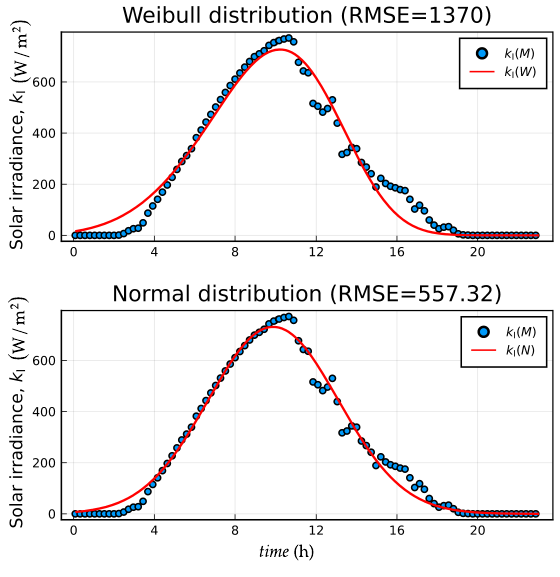
Figure 15. Solar irradiance prediction using Weibull and normal distributions for July-01-2018. Root mean square errors (RMSE) shows that the normal distribution is better than Weibull distribution. For the Weibull (cid:0) (cid:1) distribution, ( k , λ , α , β ) = 5.25,2.7 × 10 − 3 ,8.7 × 10 − 4 ,4.7 × 10 − 3 , and for the normal distribution ( µ , σ , α , β ) = (cid:0) (cid:1) 1.9 × 10 − 4 ,5.4 × 10 − 4 ,1.8 × 10 − 3 , − 2 × 10 − 3